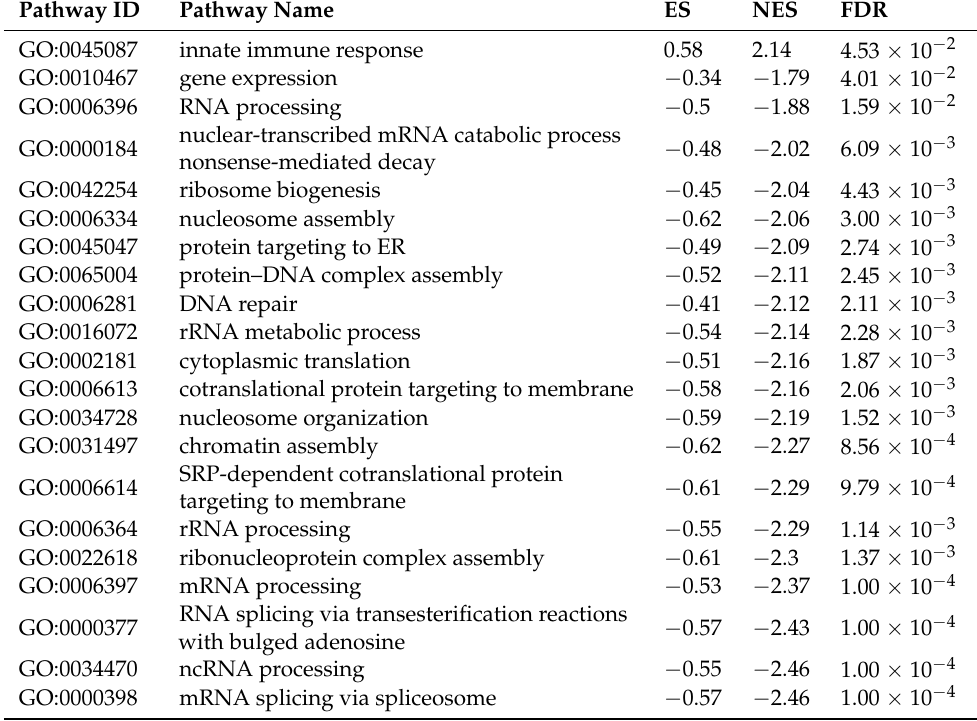
Table 3. List of statistically significant pathways, based on the list of DE genes between PC3 cells treated with XAV939+DOX 8 nM and XAV939+10 nM, according to the Gene Ontology Biological Process 2021